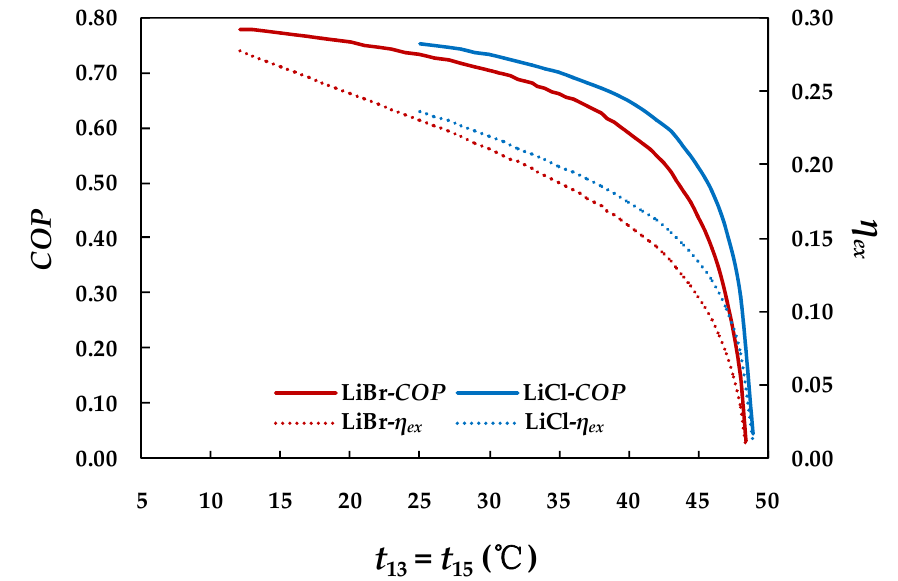
Figure 16. Variation of COP and the exergy efficiency with the cooling water inlet temperature for the two absorption chillers.